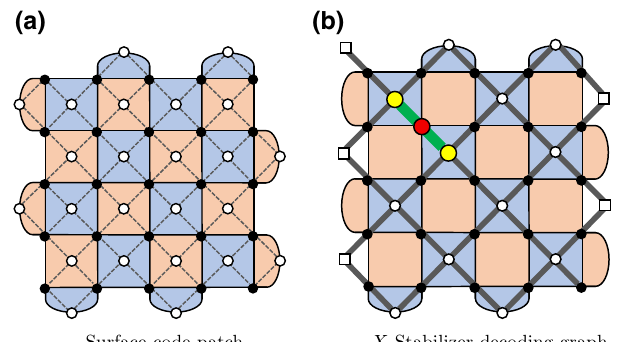
FIG. 14. (a) A d = 5 surface code patch implemented in a grid of data physical qubits (black disks), and ancilla physical qubits (white disks). Error correction is implemented with single-qubit operations and CNOT gates between pairs of qubits connected by a dashed edge. The Z - and X -type stabilizers are associated with alternating red and blue faces. (b) A decoding graph that is defined by associating an edge with each qubit and a vertex for each stabilizer. If stabilizers are measured perfectly, Z errors on data qubits (marked in red) can be corrected by finding a mini- mum weight matching (green edges) of vertices associated with unsatisfied X stabilizers (yellow disks).